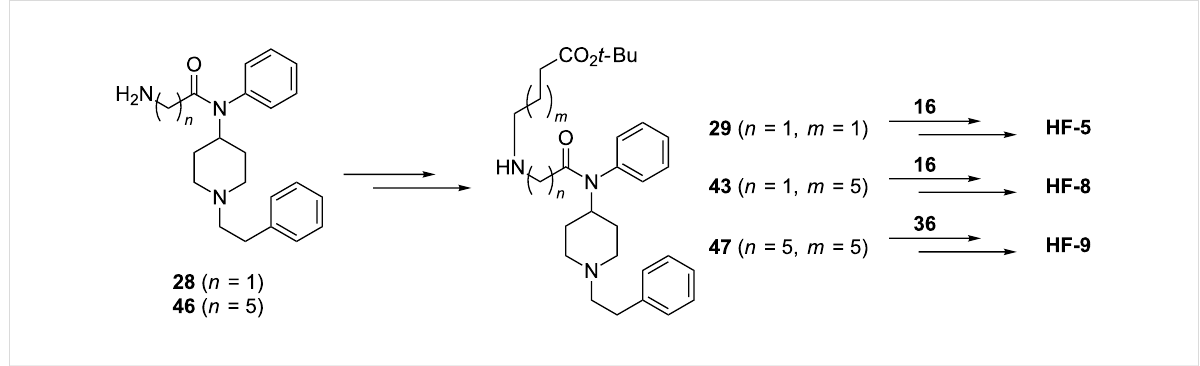
Scheme 3: General outline of HF-5 , HF-8 , HF-9 synthesis from fentanyl intermediates 28 and 46 , and heroin intermediates 16 , and 36